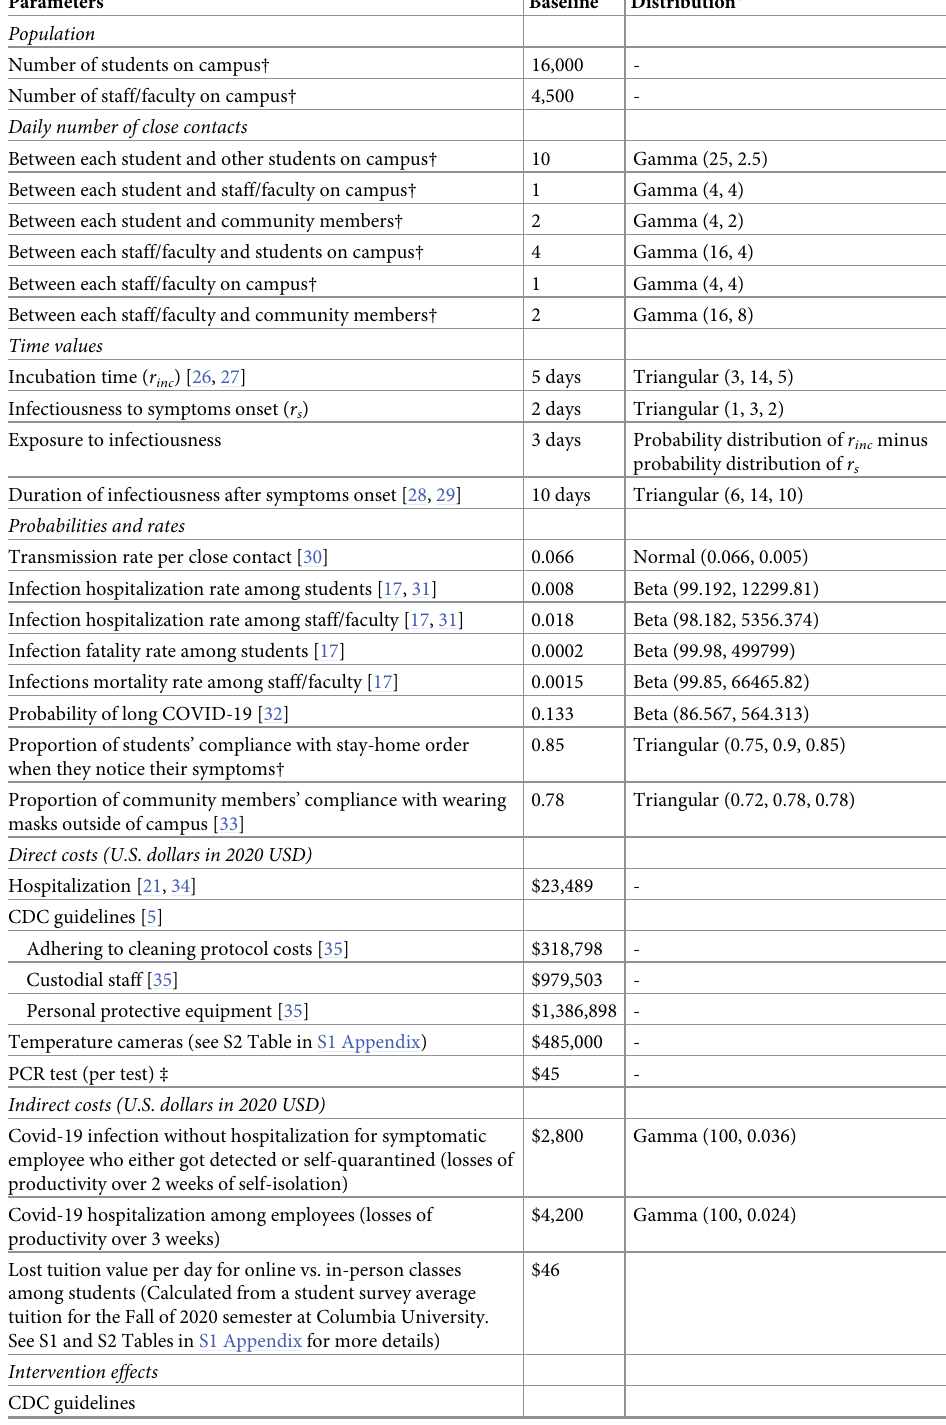
Table 2. Total costs and probabilities used as model inputs for estimating the cost-effectiveness of strategies to improve infection control for Covid-19 in a university setting with 16,000 students and 4,500 employees on cam- pus during a 90-day